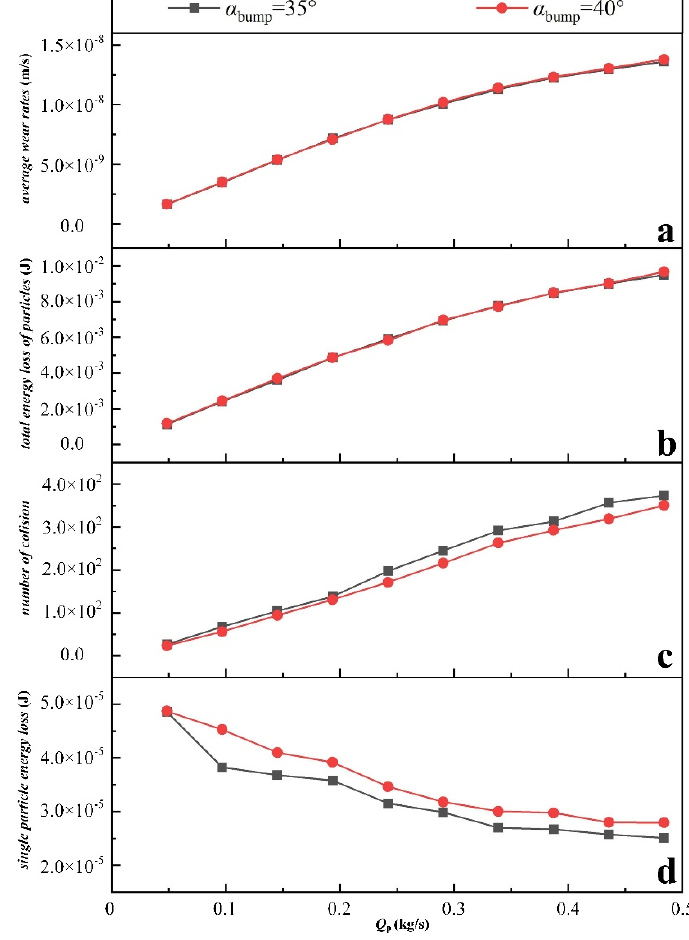
Figure 13. Correlation analysis of average wear rates, particle collision numbers, and energy losses.